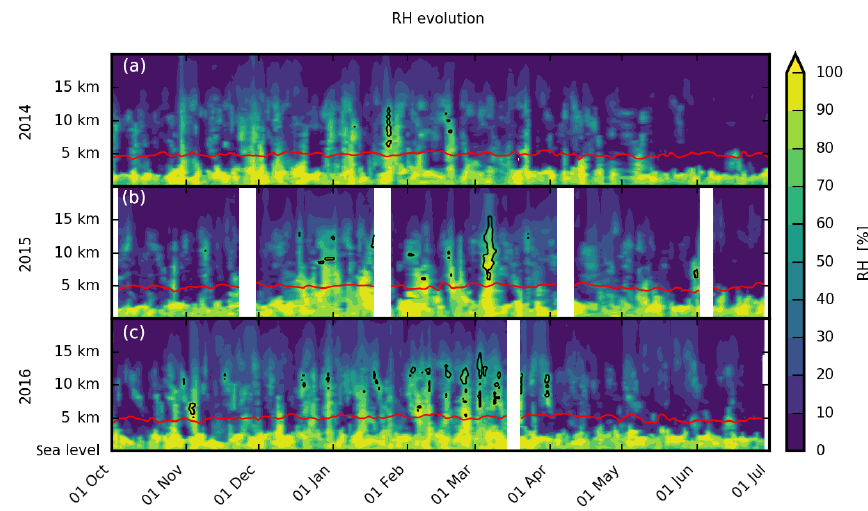
Figure 3. Time–height cross sections of day-to-day variations of relative humidity (RH) for October 2013–July 2014 (a) , October 2014– July 2015 (b) and October 2015–July 2016 (c) . The RH field is interpolated in time except when 5d of data is missing. Black contours are for RHi>100%, and the red line corresponds to the 0 ◦ C